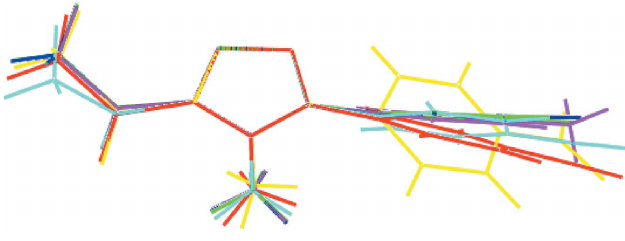
Figure 8 Overlay diagram for (I) and 4- X -phenyl derivatives: (I) (red image), X = Cl (green), X = Br (blue), X = Me (pink), X = NO 2 (first independent molecule; aqua) and X = NO 2 (second molecule; yellow). The molecules have been overlapped so that the triazolyl rings are